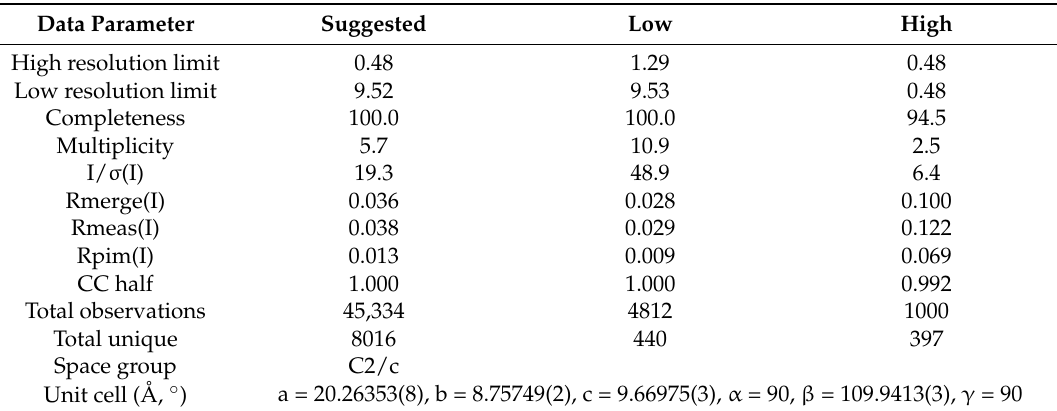
Table 2. Crystallographic data for 3,5-dinitrobenzoic acid